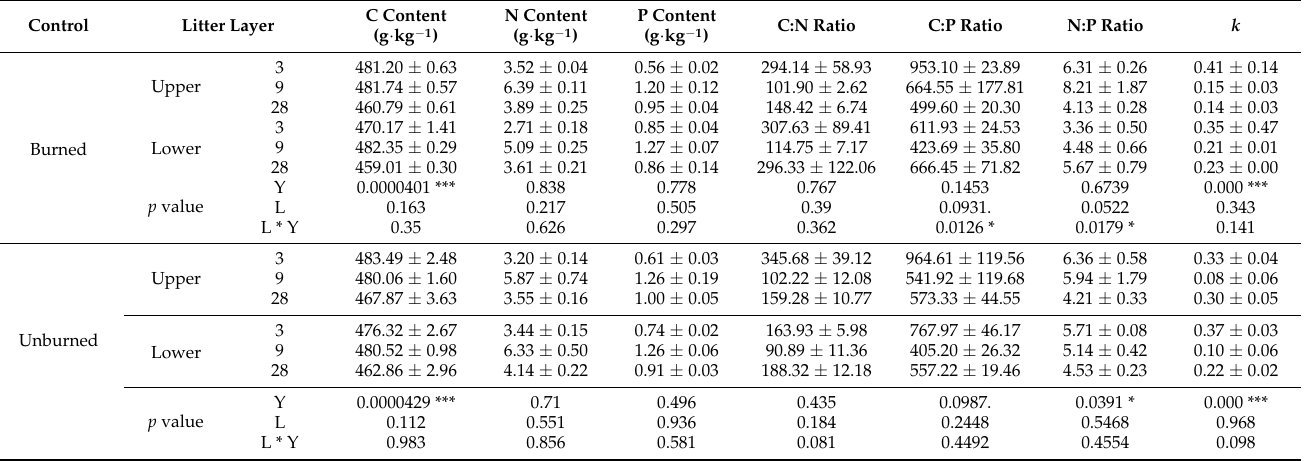
Table A2. Stoichiometric characteristics and two-way ANOVA of C, N and P in different layers of litter burned and unburned under different burning years.